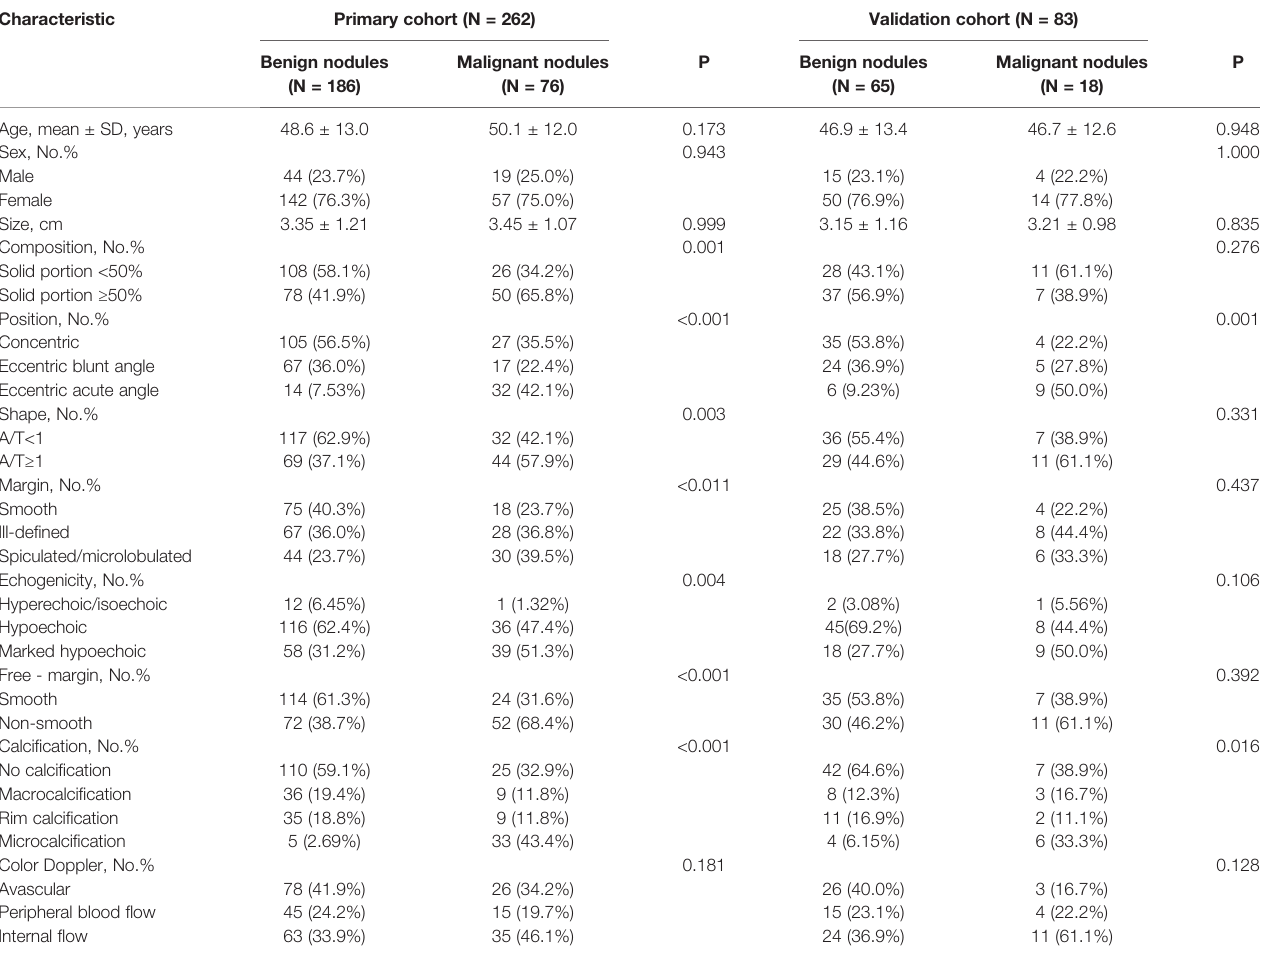
TABLE 1 | Baseline characteristics in the primary cohort and validation